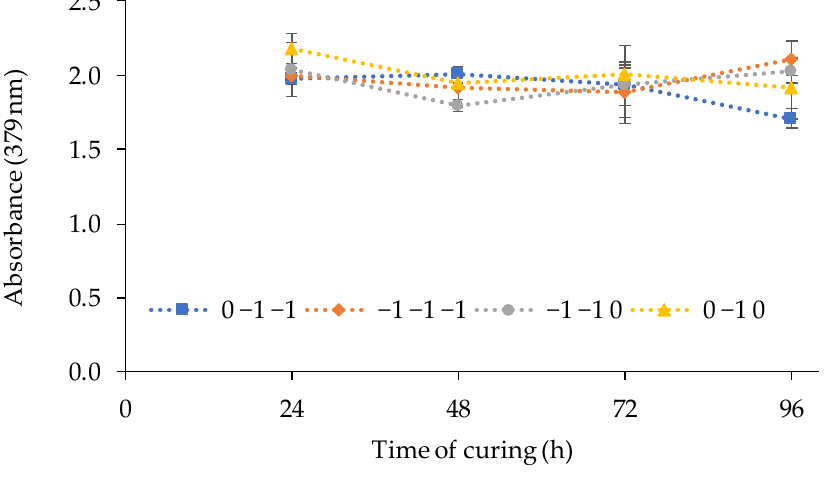
Figure 3. Effect of the curing time on the sensor response (exposed to 1 mg L − 1 of Cd(II) solutions at pH 9) for different combinations of PVC and 2-APBH levels.